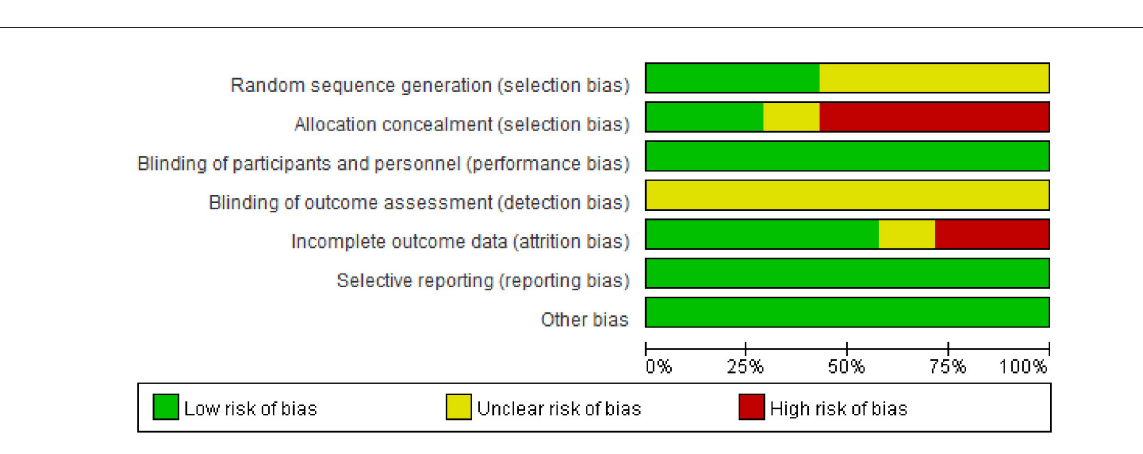
placebo control H-CS lighting therapy (CS < 0.1). All patients were diagnosed with standardized screening measures: seven datasets were based on clinical diagnosis using DSM-IV, and one used the Geriatric Depression Scale for elderly participants.